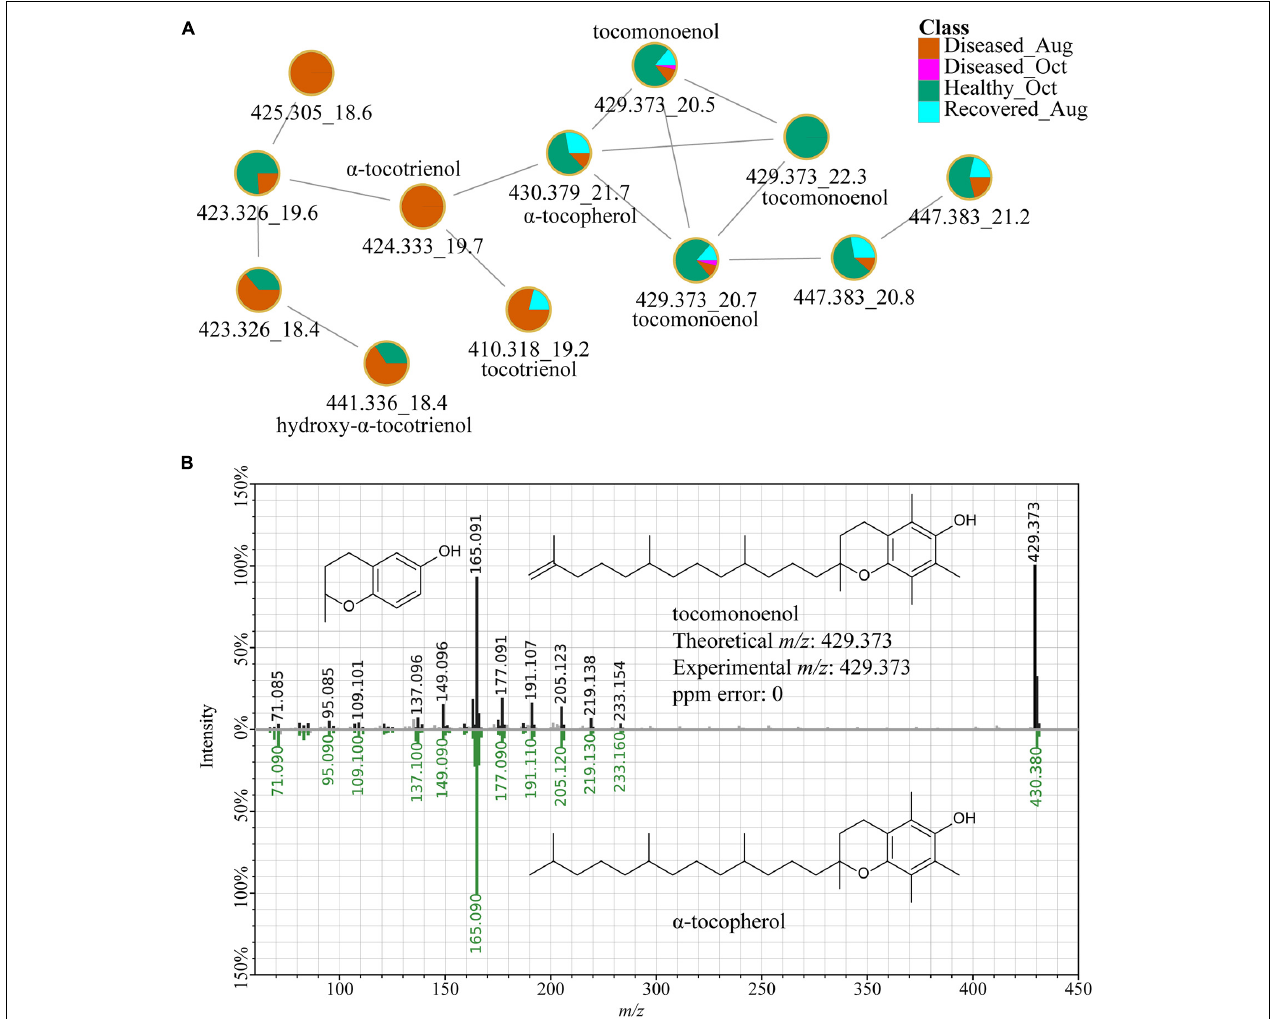
FIGURE 10 | α -Tocopherol and related metabolites. (A) Shows the FBMN of tocopherols. The MS 2 -based spectral annotations of these compounds and their distribution in corals analyzed in this study are provided in Supplementary Figures 7, 8 . The m/z _RT value is included for each feature. (B) Shows the mirror plot of MS 2 spectra of tocomonoenol acquired on extracts of coral samples (black trace) and a MS 2 spectra of tocopherol available in the NIST database (green trace) supporting the annotation of the feature with m/z 429.373 as tocomonoenol.